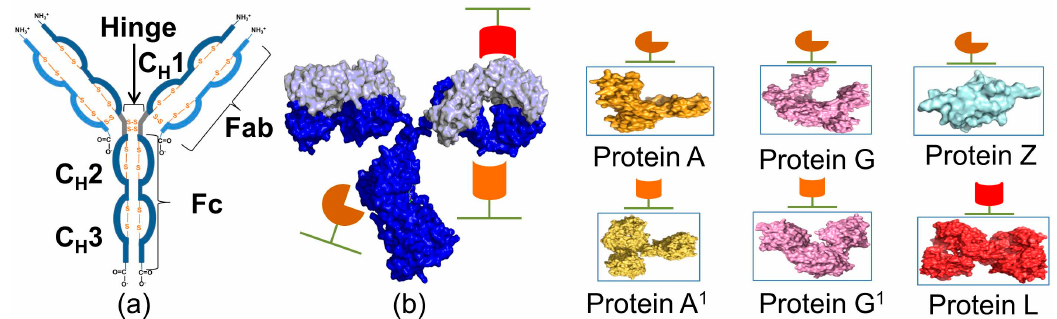
Figure 1. Illustration of an antibody and the most common bacterial proteins used. ( a ) Schematic representation of the different parts of an antibody; ( b ) pymol-generated crystal structure of IgG (pdb id: 1IGT), Protein A (pdb id: 1FC2), Protein G (pdb id: 1FCC), Protein Z (pdb id: 1Q2N),